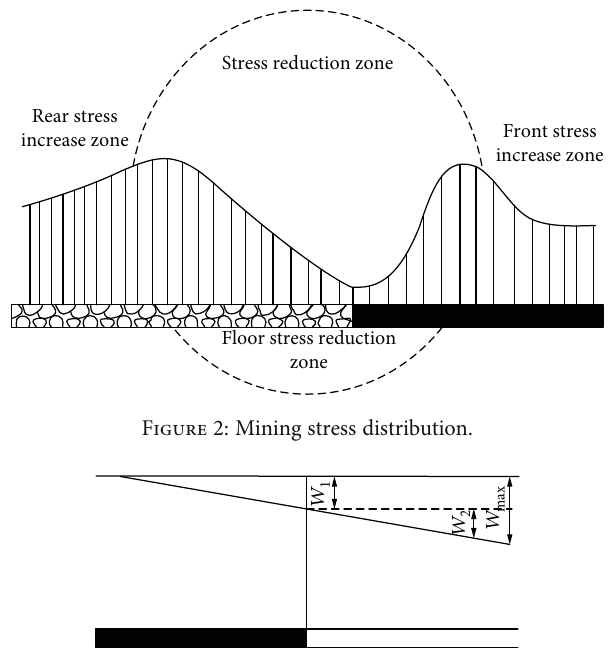
Figure 3: Surface sinking